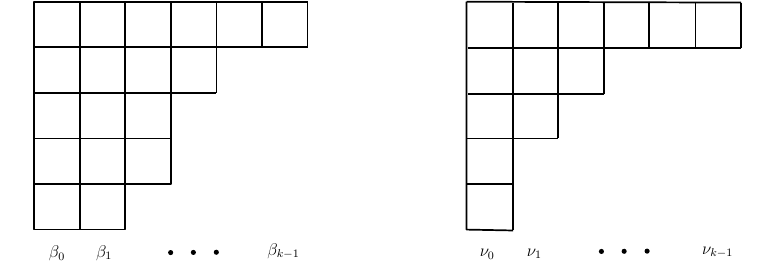
Figure 9 . Young tableaux labelling the irreducible representations of U( α k ) and U( µ k )